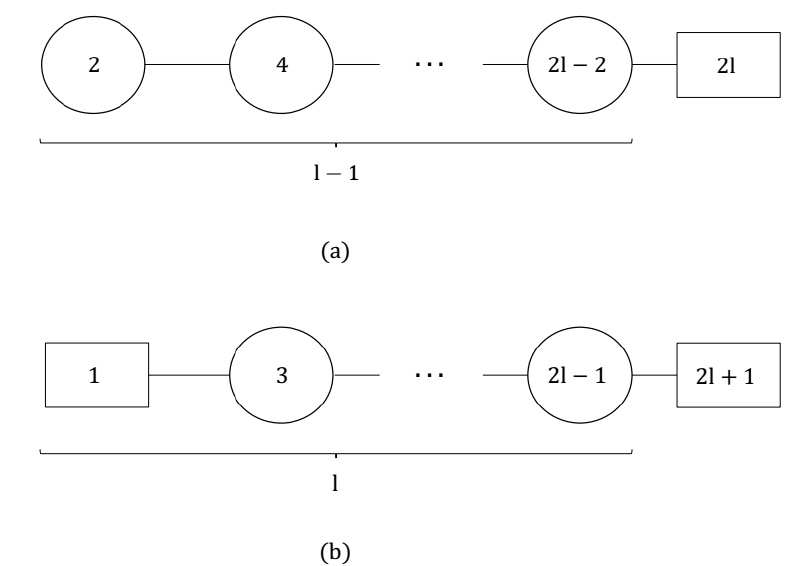
Figure 8 . Quivers of the 4 d gauge theory that is expected to exist, on a generic point on the Coulomb branch spanned by the operators descending from the tensor multiplets, for theories resulting from the Stiefel-Whitney compacti(cid:12)caton of the theories in (cid:12)gure 7.